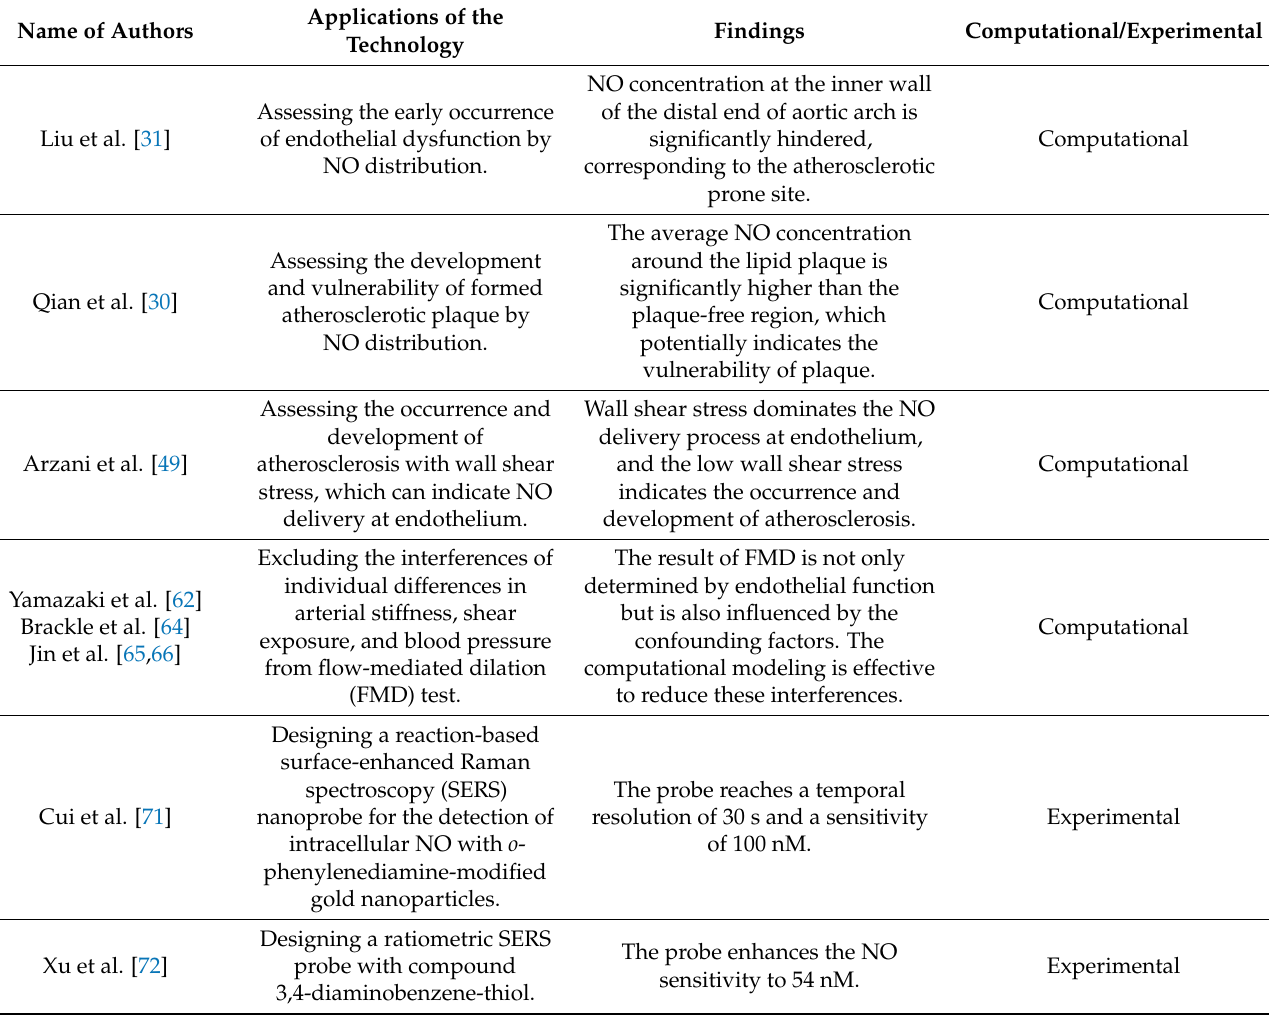
Figure 3. The emerging technologies to experimentally measure cardiovascular nitric oxide. ( a ) The schematic diagram of surface-enhanced Raman spectroscopy (SERS). A large enhancement in the Raman signal can be observed when nitric oxide (NO) is absorbed or lies close to the enhanced field at the surface. ( b ) The cardiovascular application of fiber optic Raman spectroscopy [75]. ( c ) The flexible and degradable electrochemical sensor to achieve real time measuring of NO delivery in rabbit, and the signal of NO concentration in various tissues [80]. Table 1. The available technological advancements in diagnostic measuring of NO delivery process.